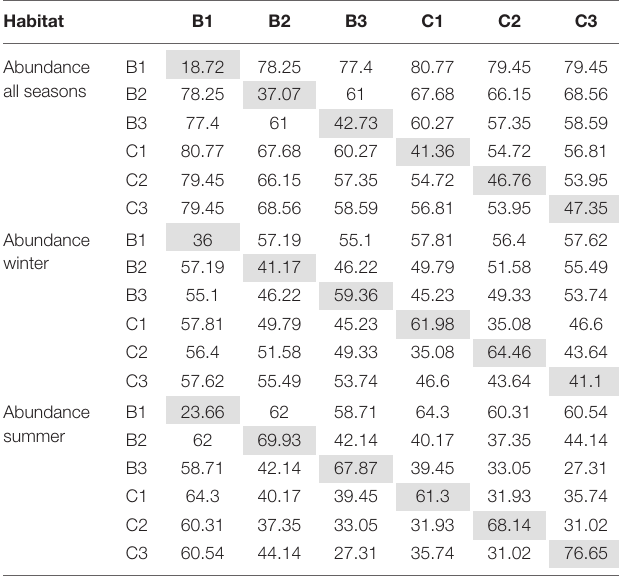
TABLE 5 | Based on abundance of traits, the SIMPER analyses present similarities within habitats (gray cells) as well as dissimilarities between habitats for trait composition during all seasons, winter and